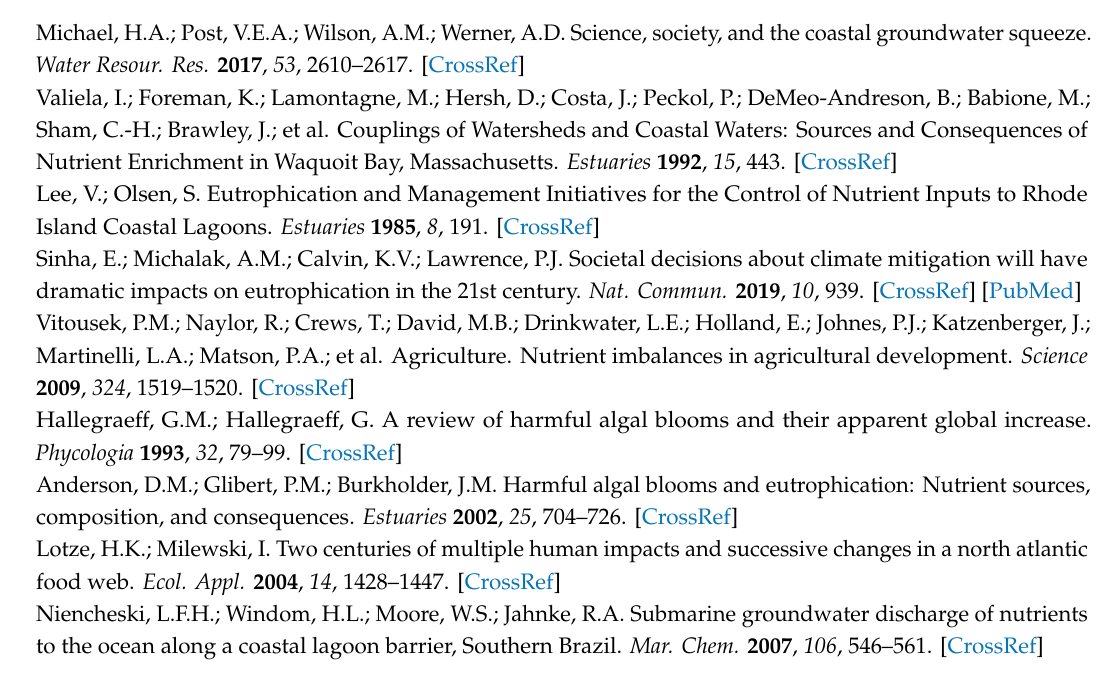
Table S1: In situ measurements, stable isotopes, nutrient and ion analysis for sampling points 1 to